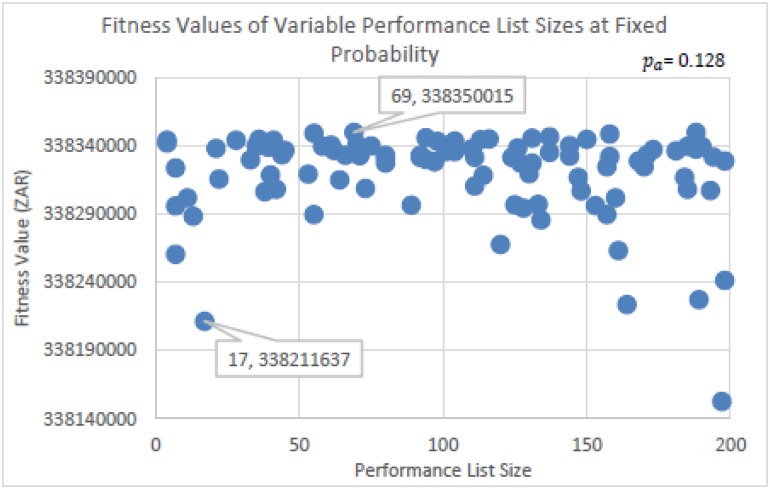
Zoomed in image of Fig 5.